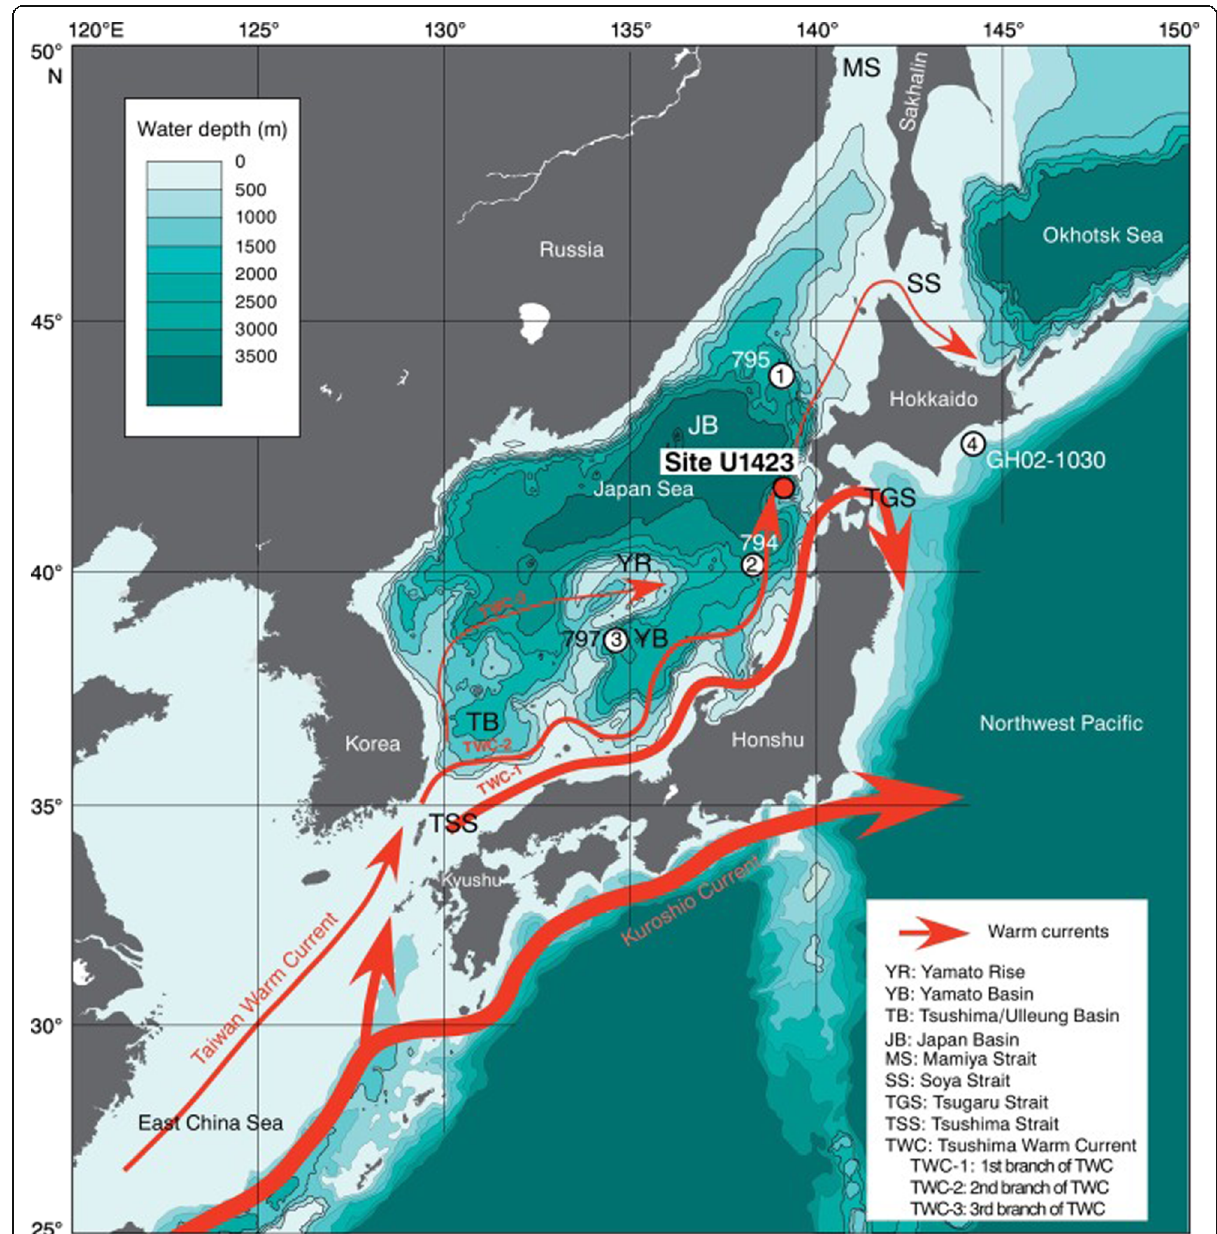
Fig. 1 Map showing the studied sea area and location of Site U1423. The locations of ① Site 795, ② Site 794, and ③ Site 797 in Heusser (1992) and ④ Site GH02 – 1030 in Igarashi et al. (2011) are also shown (from Igarashi et al.